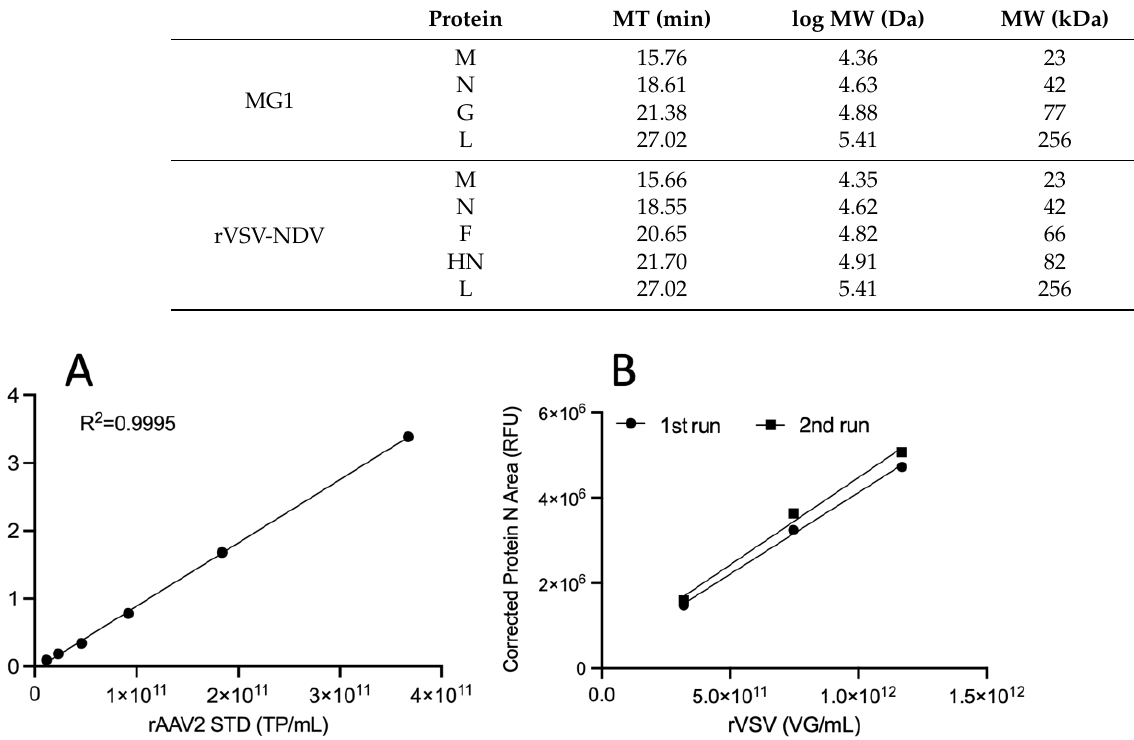
Figure A2. ( A ) Linear representation of fluorescence response vs rAAV2 total particles (TP/mL) concentration (average of analyst 1 run 1 assay). ( B ) Linear representation of fluorescence response vs MG1 concentration (VG/mL).